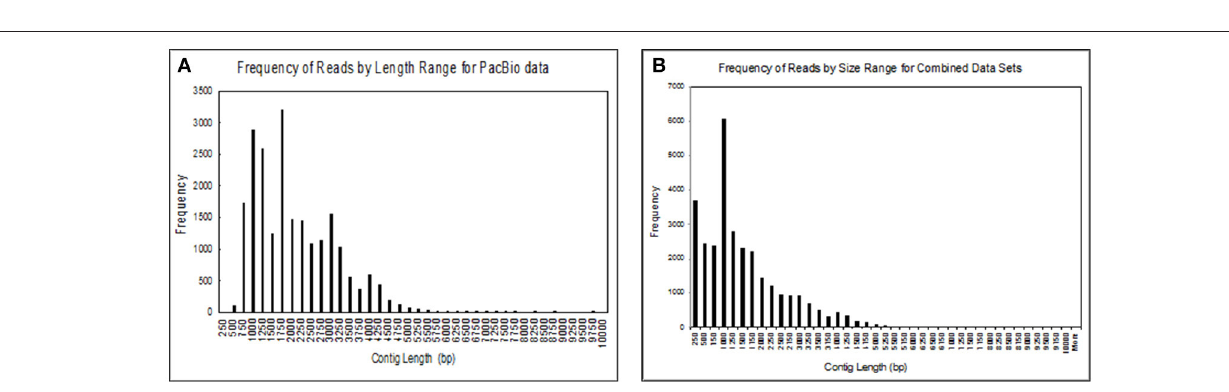
Frontiers in Endocrinology |